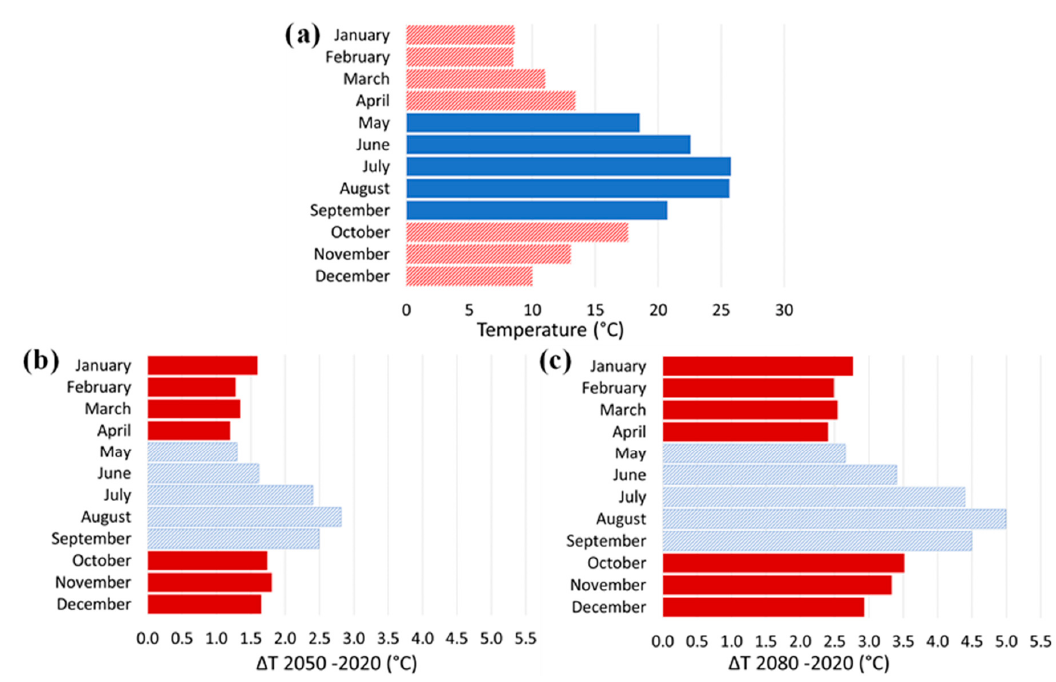
Figure 4. Monthly average air temperature: ( a ) in 2020, and monthly average air temperature increment Δ T ( b ) in 2050 and ( c ) in 2080.